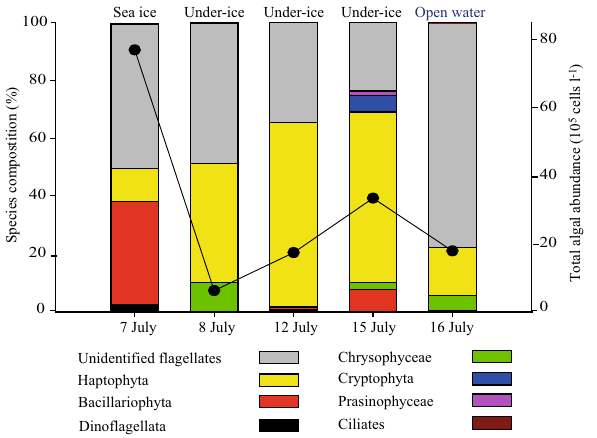
Figure 3. Algal community composition. Temporal development of algal species composition (%) in the entire Sea ice column and under-ice water at 1 m (bars) and the total algal abundance (black circles).